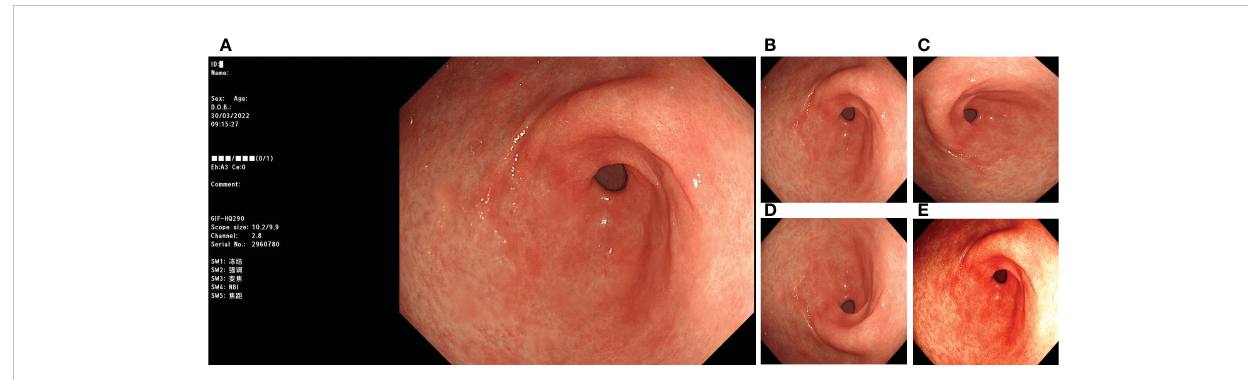
FIGURE 1 Image preprocessing. (A) original image; (B) invalid area removed, resize to 512*512 pixels; (C) rotate 90°counterclockwise; (D) fl ip vertically; (E) color random